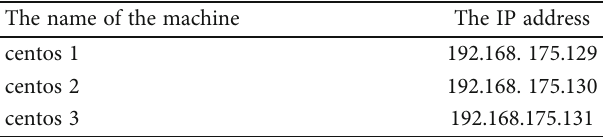
Table 6: Host name settings.